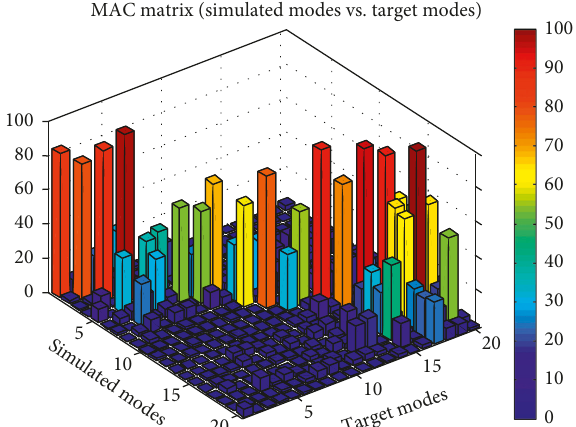
Figure 24: MAC of configuration 5.